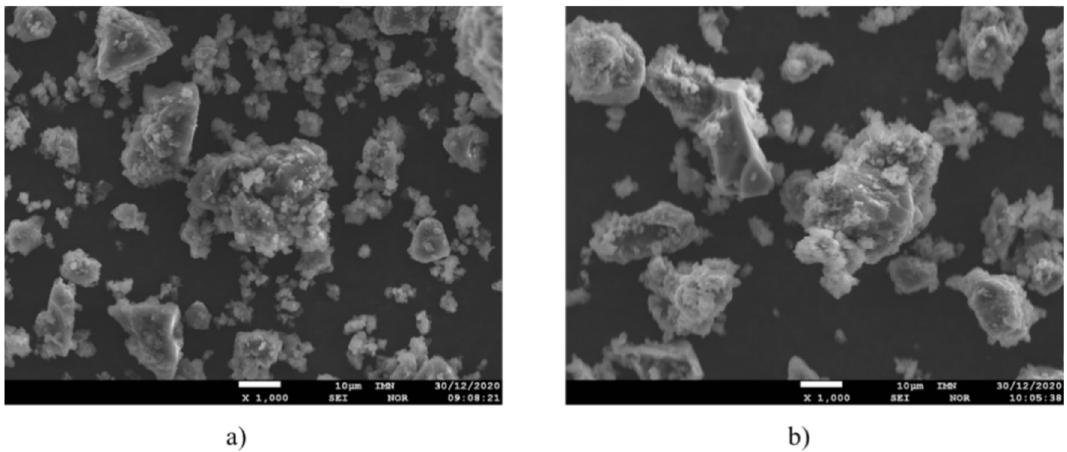
Figure 5. SEI microscopic picture of the char obtained at the maximum temperature 400 ◦ C; zoom 1000 × . ( a ) pre-consumer waste, ( b ) post-consumer waste.